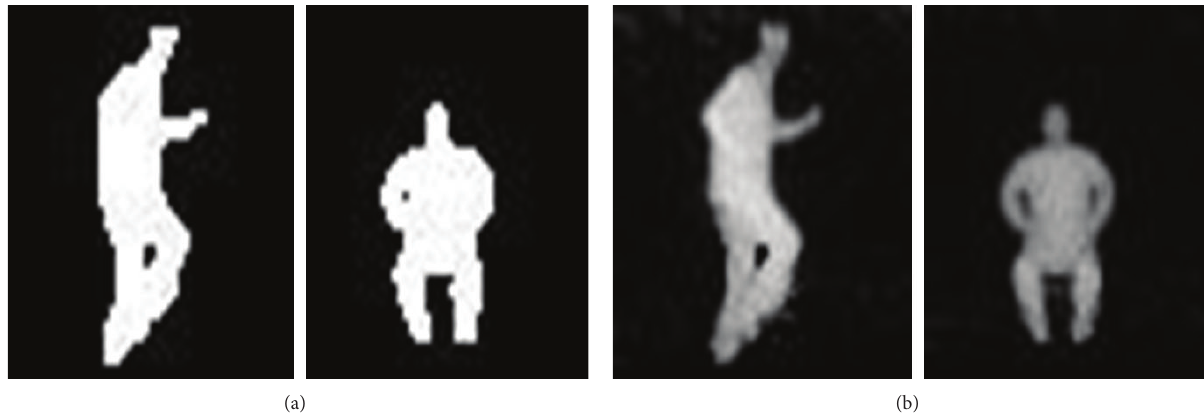
Figure 2: Images comparison as (a) binary silhouettes and (b) depth silhouettes of exercise and sit-down activities.